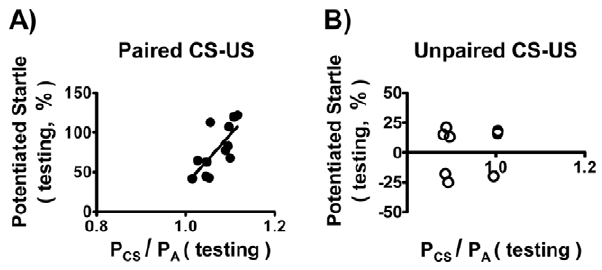
Figure 7. Correlation between potentiated startle and P CS /P A (testing) values. P CS /P A (testing) values were obtained by measuring the 3-s averaged BP values before and after the light (CS) during the testing session (averaged 10 times of the CS-evoked response for each rat, n=12).